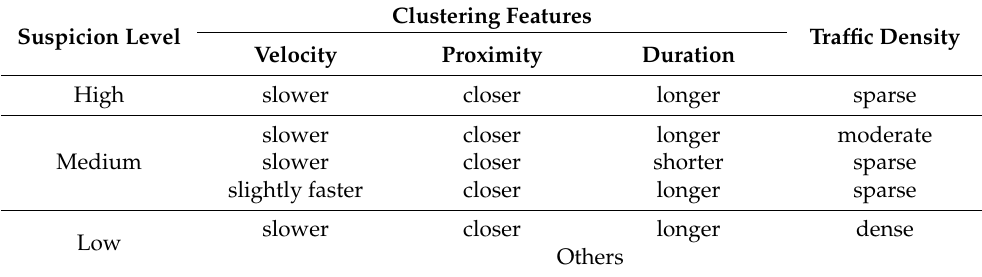
Table 1. Classification of suspicion